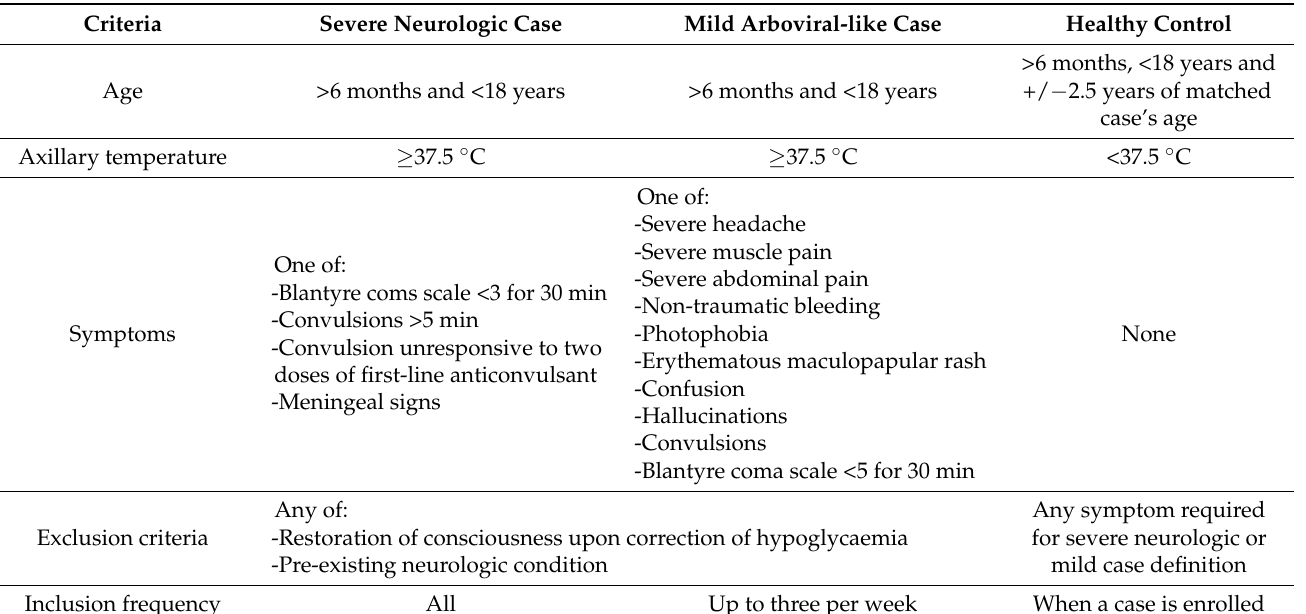
Table 1. In- and exclusion criteria.